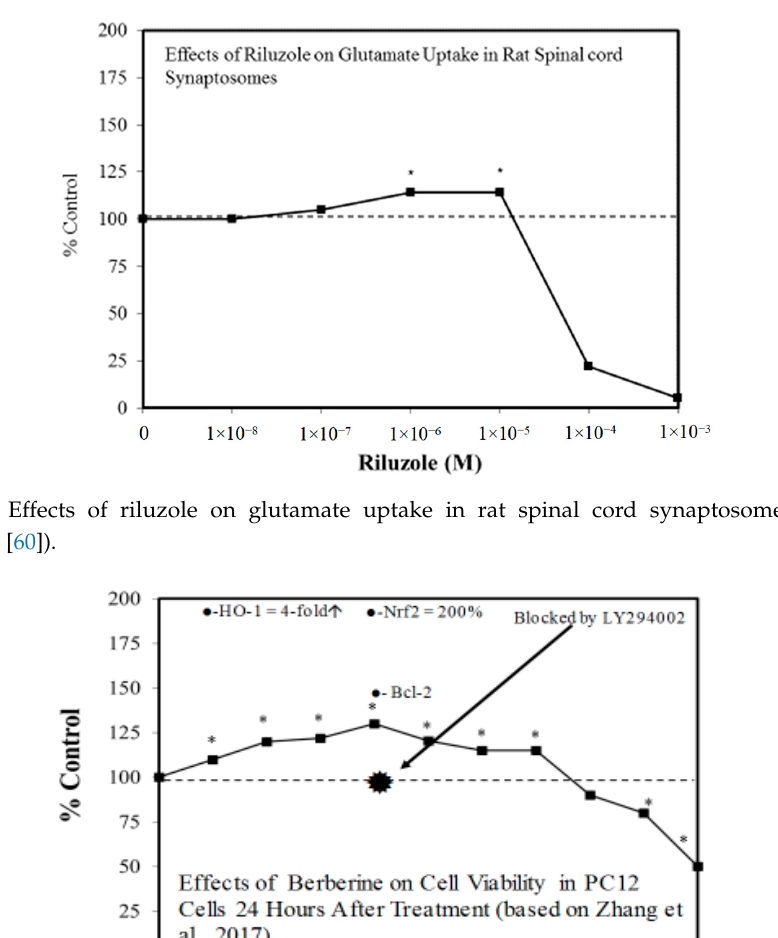
Figure 4. β -amyloid peptide (A β )42 has a hormetic effect on hippocampal long-term potentiation (Source: Puzzo et al. [59]).